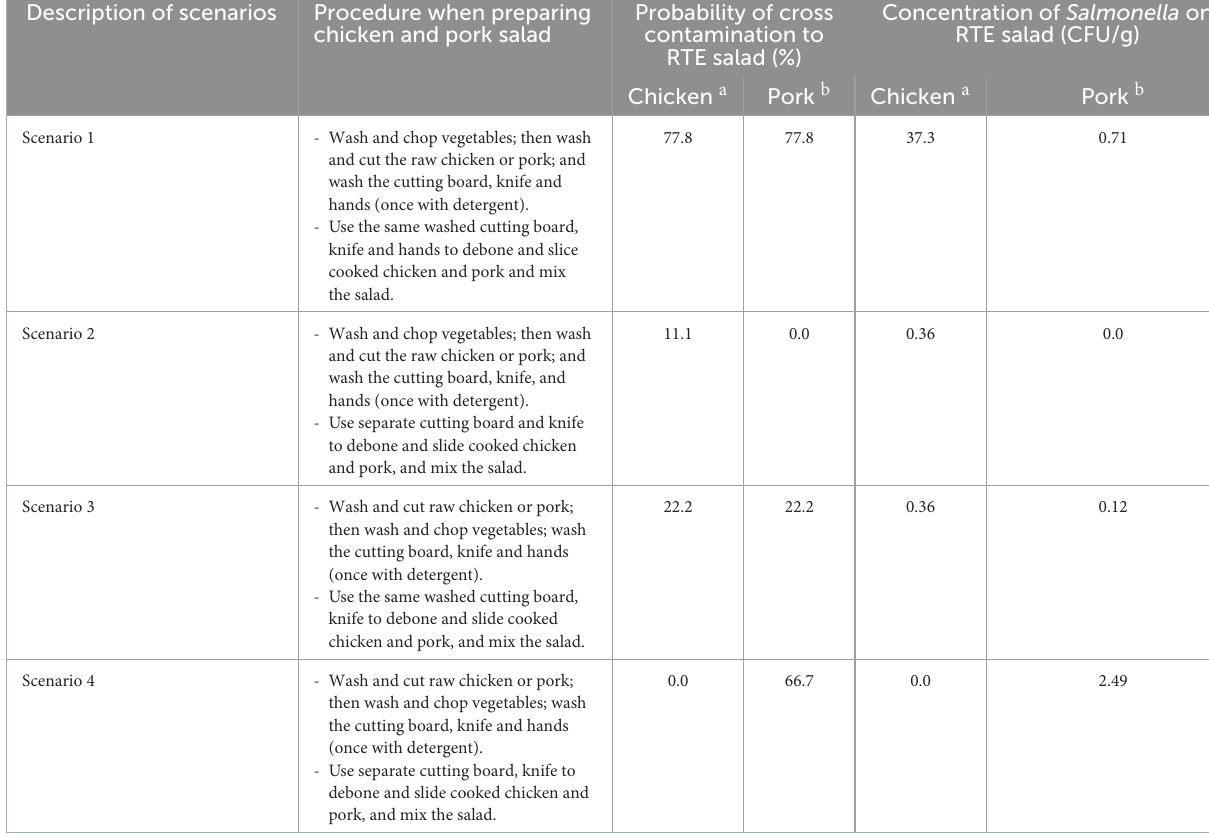
TABLE 1 Description of the four scenarios where cross-contamination of Salmonella may occur when preparing chicken and pork salad. Description of scenarios Procedure when preparing chicken and pork